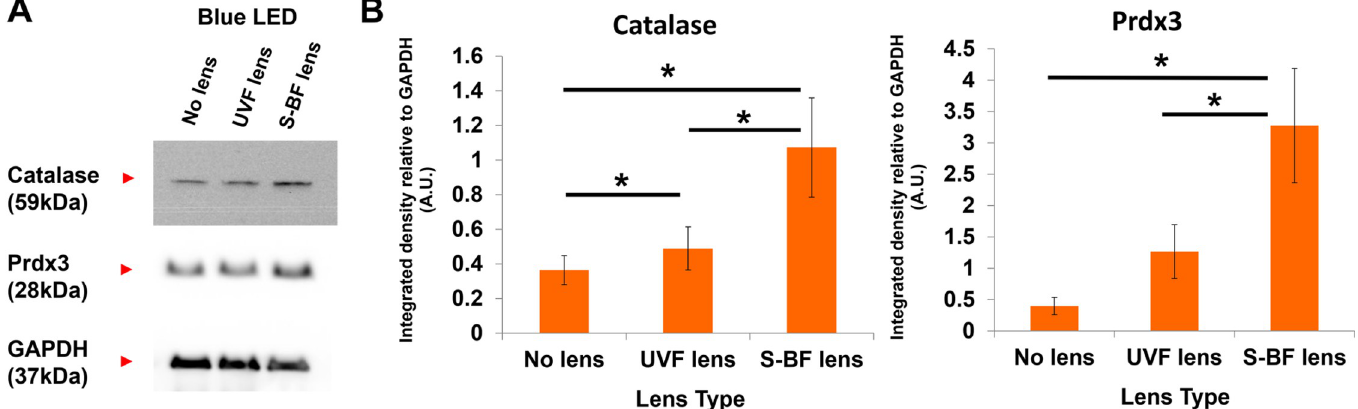
Fig 9. Protein expression of anti-oxidative enzymes in the UV-Filtering (UVF), Selective Blue-Filtering (S-BF) and no lens groups under blue LED irradiation. (A) Representative western blot of the anti-oxidative enzymes catalase and Prdx3. GAPDH was used as a loading control. (B ) Quantification analysis of protein levels of catalase and Prdx3. Under blue light irradiation, S-BF lens showed higher expression of catalase than no lens (p = 0.035) and UVF lens (p = 0.020). UVF lens also showed a higher level of catalase compared to no lens (p = 0.040). The S-BF lens showed a higher expression level of Prdx3 than no lens (p = 0.026) and UVF lens (p = 0.028). A.U.: arbitrary unit. (n = 3, one way ANOVA, � p < 0.05) The values are expressed as Mean ± SEM.